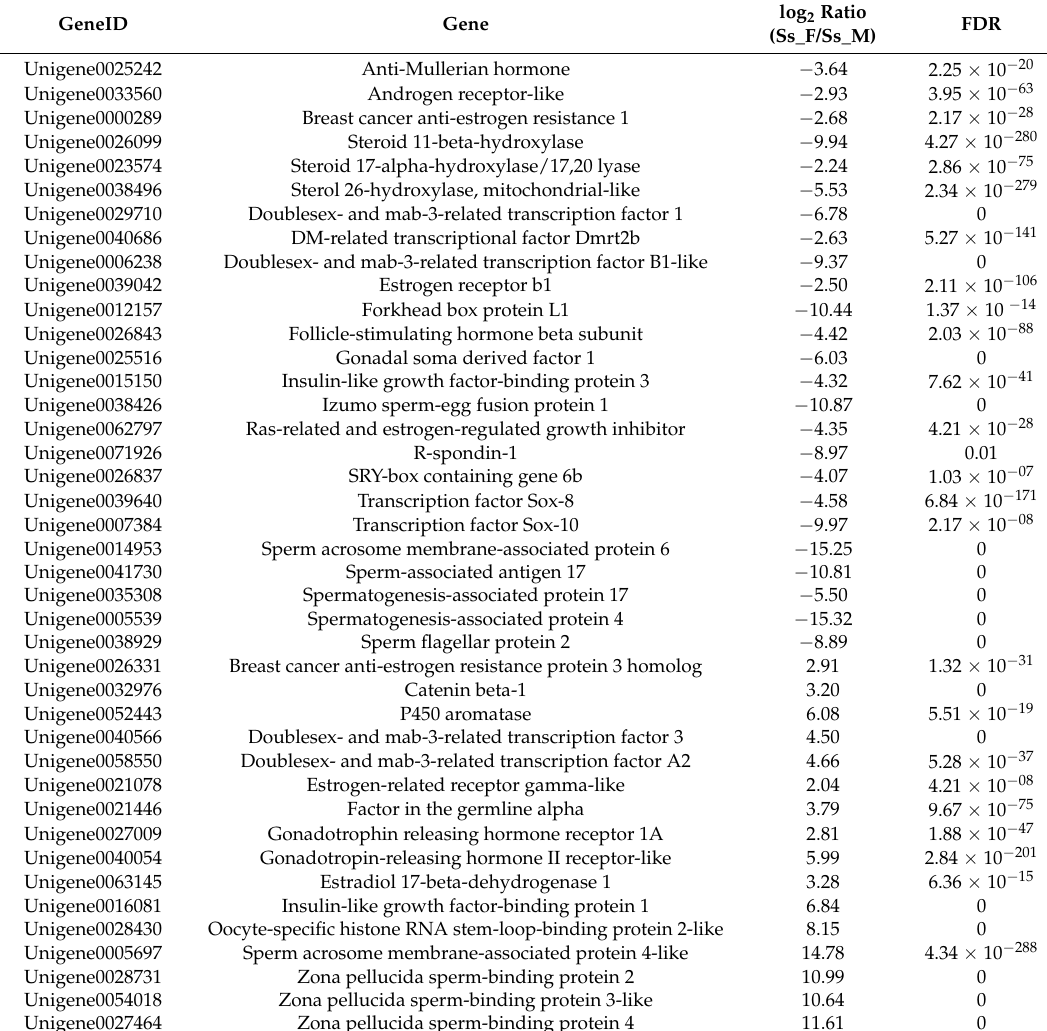
Table 3. List of putative genes significantly expressed in male and female gonads of S. sihama